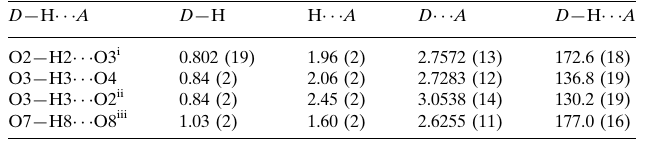
Hydrogen-bond geometry (A˚ , (cid:2)